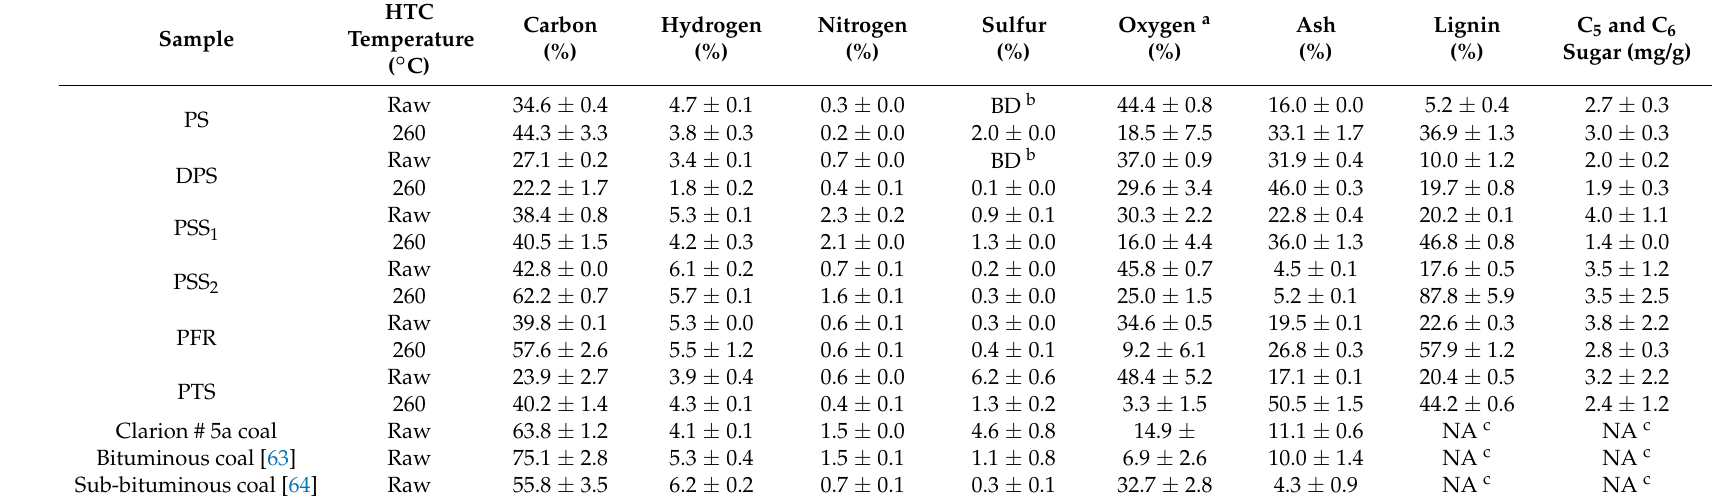
Table 3. Ultimate analysis, ash and lignin number for all raw and hydrochar samples ( a indicates that it was calculated by difference; b Below detection limit; and c Not